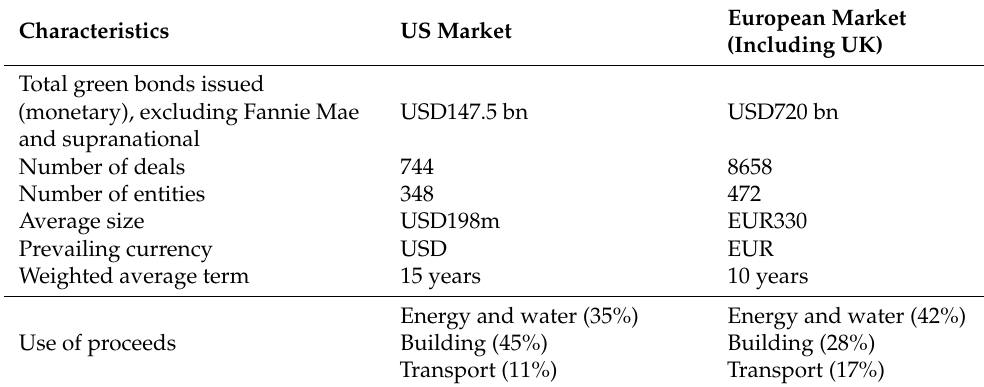
Table 1. Current state of corporate green markets in US and Europe (cumulative as for Q1 2021).